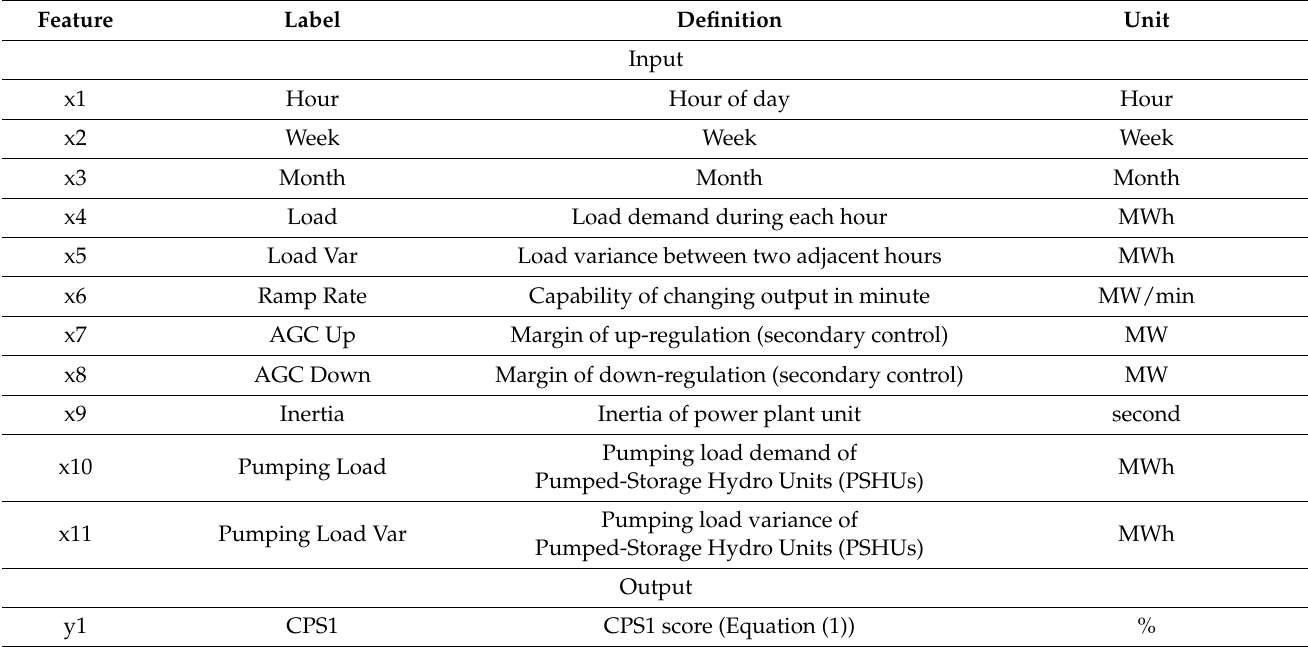
Table 1. Frequency-sensitive features for the Taipower system.